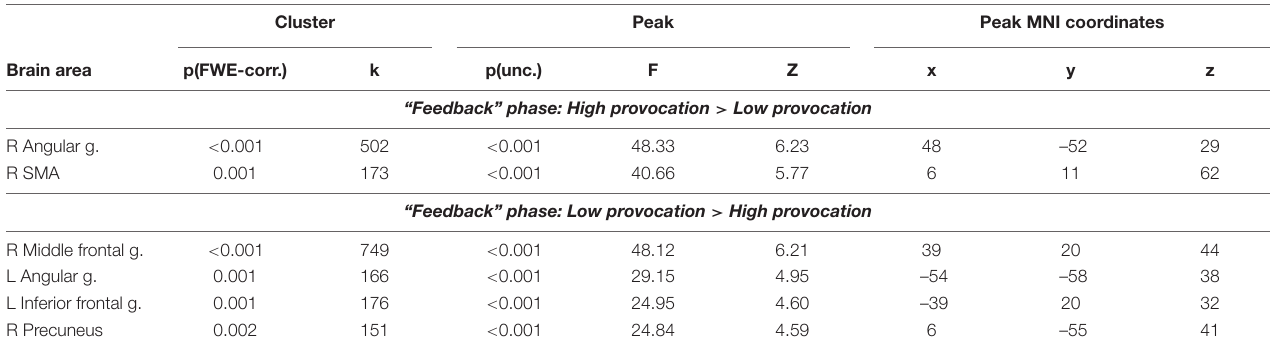
TABLE 4 | Results of the group-level analysis of the BOLD signal associated with the observation of provocation (uncorrected p < 0.001 at the voxel level, FWE-corrected at the cluster level p < 0.05, and k = 15). Cluster Peak Peak MNI coordinates Brain area